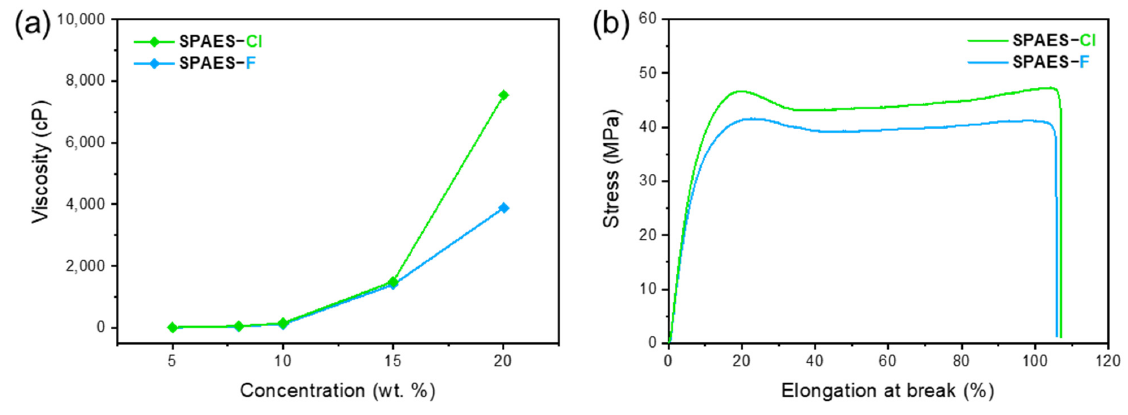
Figure 4. ( a ) Solution viscosity and ( b ) stress–strain curves of SPAES copolymer membranes.